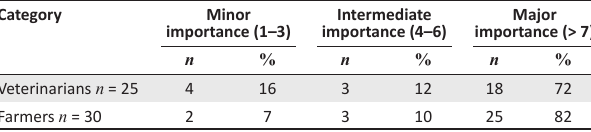
TABLE 1: Rating of importance of heartwater in the veterinarians’ or farmers’ areas. Category